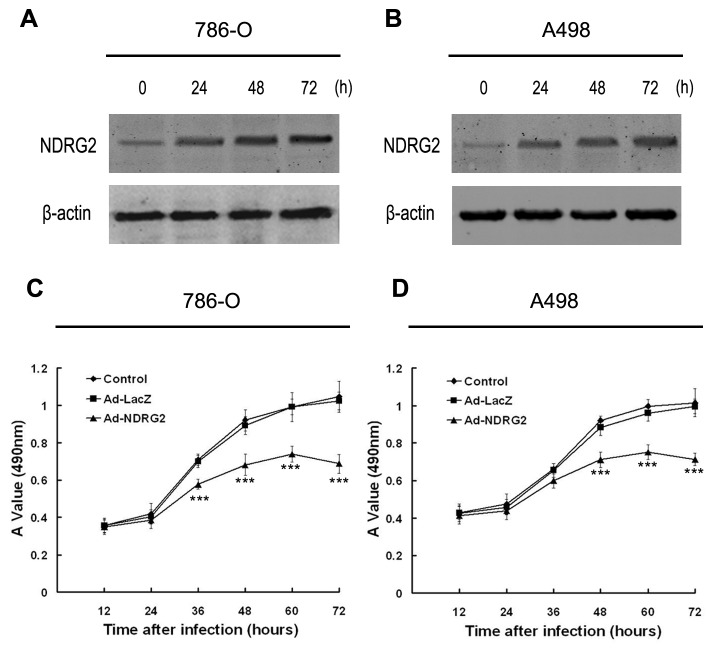
Effect of NDRG2 on proliferation of renal cancer cells.(A and B) Expression levels of NDRG2 protein in Ad-NDRG2-infected 786-O and Ad-NDRG2-infected A498 cells were respectively examined by Western blotting. (C and D) The growth of the 786-O and A498 cells was inhibited by the overexpression of NDRG2 after 72 hours of incubation. Statistical significance was assessed using one-way ANOVA. *** indicates P < 0.001, when compared with the Ad-LacZ group.